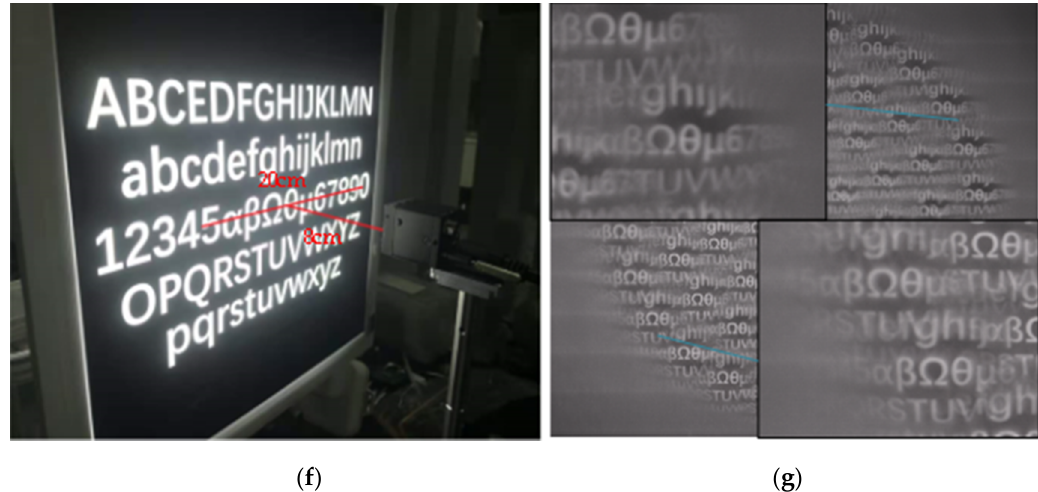
Figure 10. Optical characterization of the curved compound eye. ( a ) The setup to capture the focal spot; ( b ) the focal spot of each ring; ( c ) normalized intensity distribution of the curved compound eye; ( d ) the point spread function (PSF) of the central ommatidium; ( e ) the resolution target captured by the lens; ( f ) the setup to measure the field of view; ( g ) the letters captured by the camera.